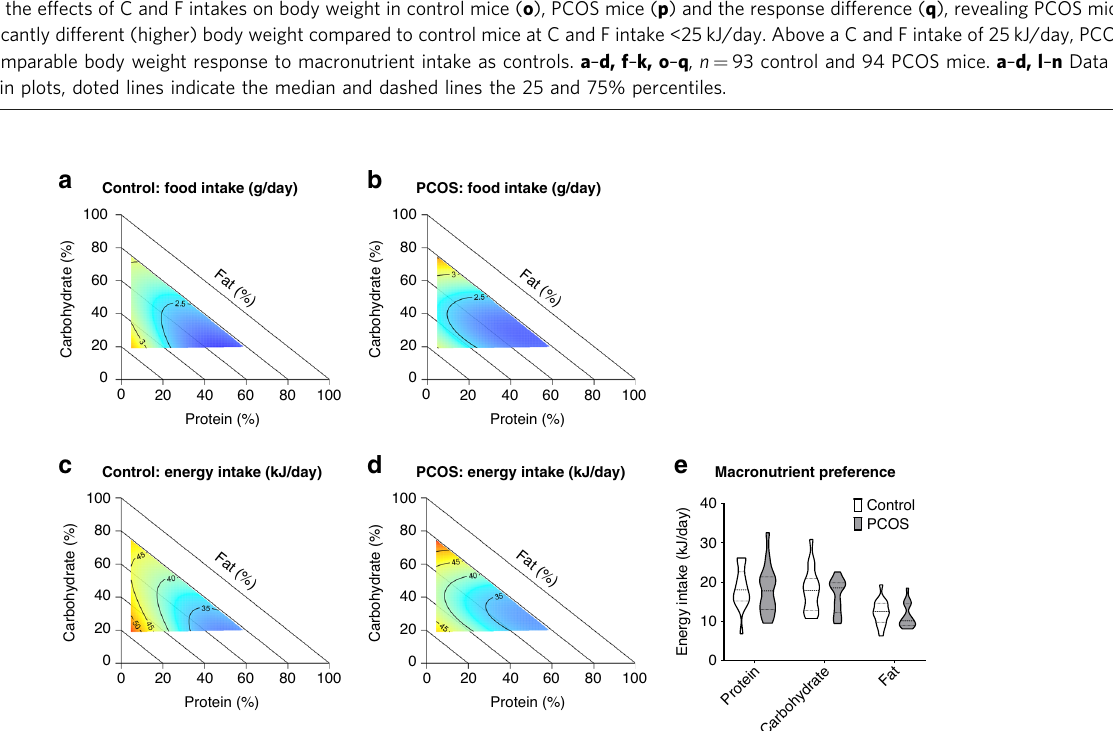
Fig. 2 PCOS mice gain excess weight regardless of macronutrient balance. a Body weight; regardless of diet PCOS mice exhibit increased body weight ( P < 0.001). b Body fat (g), calculated by dual-energy x-ray absorptiometry (DEXA), showing that PCOS mice display a signi fi cant increase in body fat ( P = 0.0005). c Fat depot weights showing a signi fi cant increase in adiposity in PCOS mice ( P < 0.05). d Lean body mass (g) calculated by DEXA, showing that